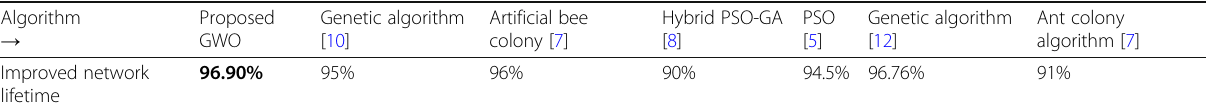
Table 4 Comparative analysis of the proposed algorithm with existing in WBAN problem Algorithm